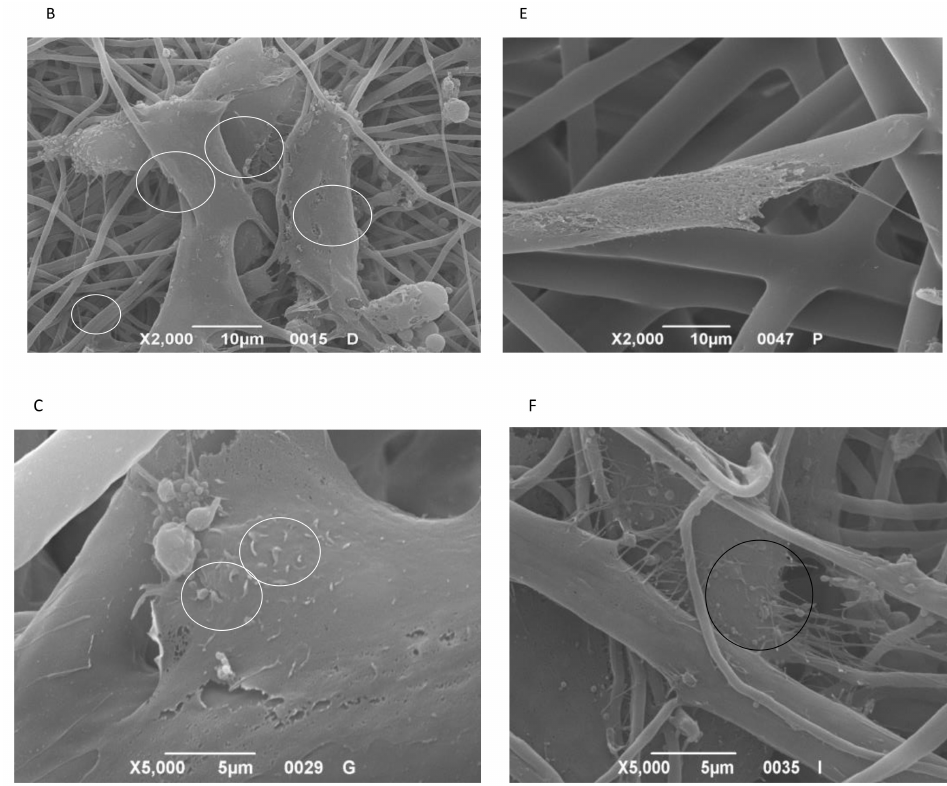
Figure 6. SEM images of Endothelial cells ( A – C ) and Fibroblast ( D – F ) after 3 days of culture on PCL plus gelatin at 200 × ( A , D ), 2000 × ( B , E ) and 5000 × ( C , F ).